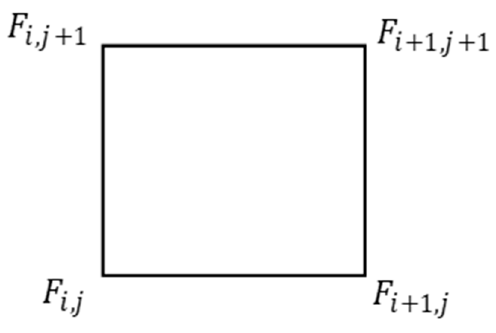
Figure 1. Pixel points of image.